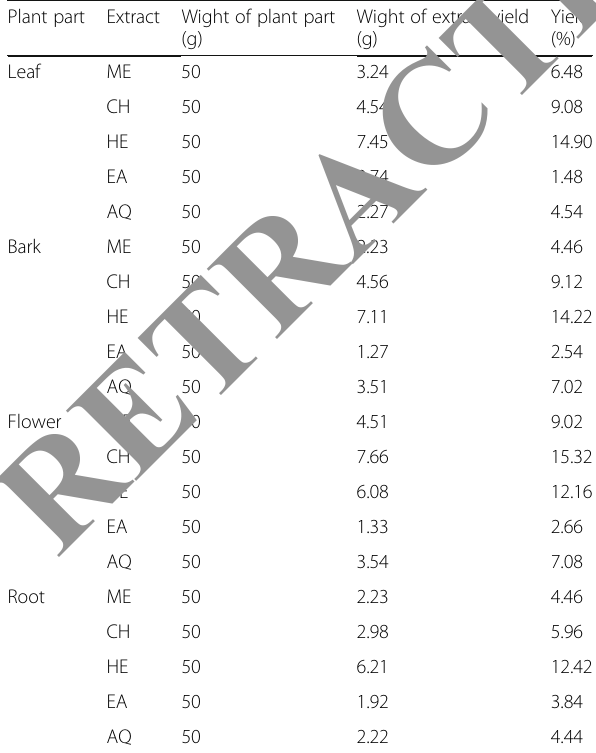
Table 1 Weight and percentage yield of different crude extracts of Pongamia pinnata Plant part Extract Wight of plant part